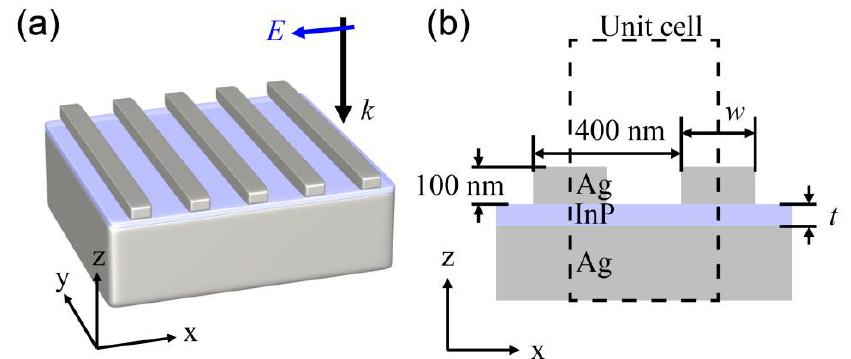
Figure 1. ( a ) 3D and ( b ) 2D schematics of the color detector. The Ag rectangular parallelepiped shaped strips are placed on the active layer. The strips are arranged with a one-dimensional periodicity of 400 nm and a height of 100 nm. The active layer composed of InP is between the Ag substrate and the strips. The width of each strip ( w ) and thickness of the layer ( t ) are key parameters to control the absorption of the active layer. The unit cell for computing is defined from the center of the strip to the center of the next strip.